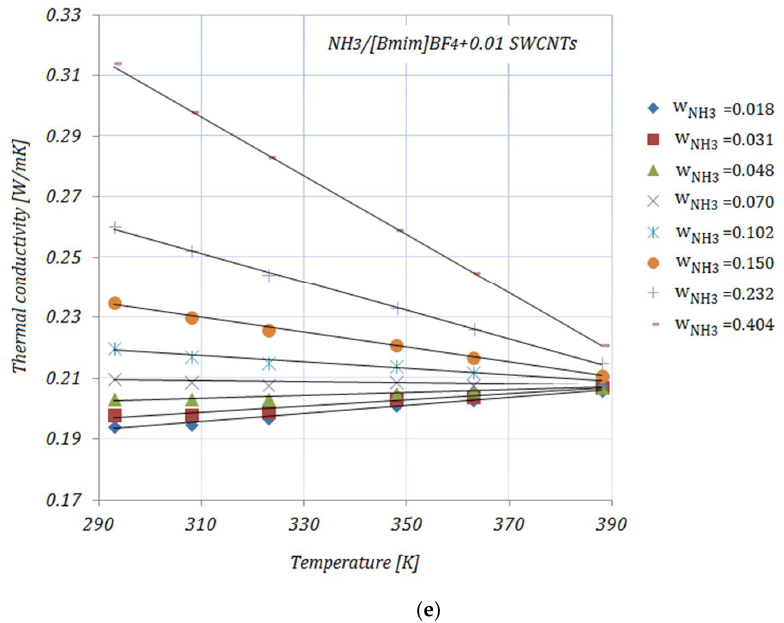
Figure 1. - Solution thermal conductivity. Figure 1. Solution thermal conductivity.